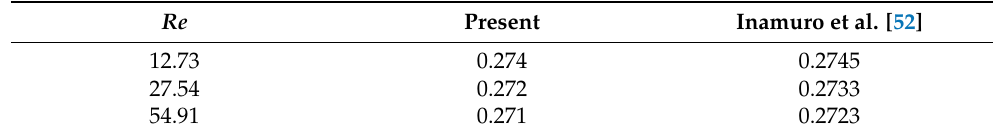
Figure 4. Computational model of straight channel Table 2. Equilibrium position 𝑦 (cid:3043),(cid:3032)(cid:3044) in straight channel with 𝐿 (cid:3045) × 𝐿 (cid:3051) = 200 × 200 cells for 𝑅𝑒 = 12.73, 27.54, 54.91 and 𝐶 = 0.25 Table 2. Equilibrium position y p , eq in straight channel with L r × L x = 200 × 200 cells for 𝑹𝒆 Present Inamuro et al. [52] Re = 12.73, 27.54, 54.91 and C = 0.25.